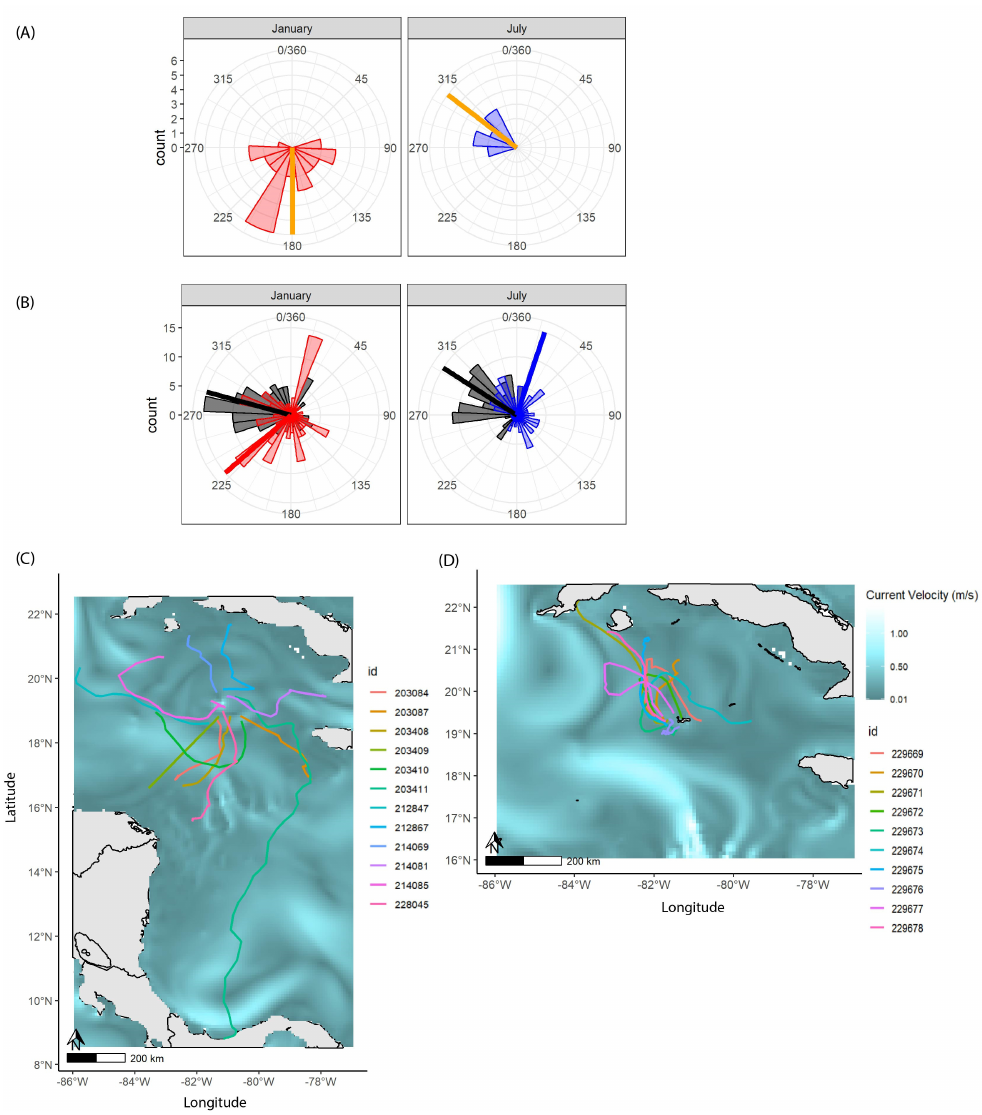
Figure 1. ( A ) Circular histograms of the initial heading (first two reported locations) of turtles released in January ( N = 28, red) and turtles released in July ( N = 10, blue), with the initial direction of the surface drifter shown (orange). ( B ) Circular histograms of overall mean daily surface current directions (black) versus January track (blue) headings and July track (red) headings, with thick colored lines showing circular means for each group. Trajectories for dispersive turtles in January ( N = 28) ( C ) and July ( N = 10) ( D ) plotted over ocean surface current fields averaged over the maximum duration of the tracks from each tracking period (January: 28 days, July: 10 days). Surface current velocity fields were provided by the Copernicus Marine Service (https://marine.copernicus. eu/ accessed on 2 February